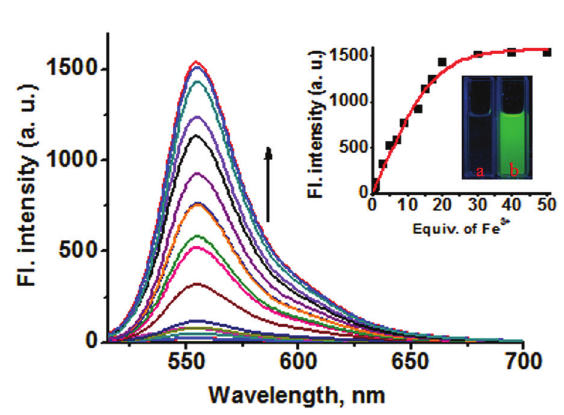
Figure 3: Plot of fluorescence intensity of sensor Rh6G-1 (10 μM) at 556 nm vs. Fe 3+ concentration (1 - 170 μM) in water (containing 1% DMSO as a cosolvent) excited at 500 nm.